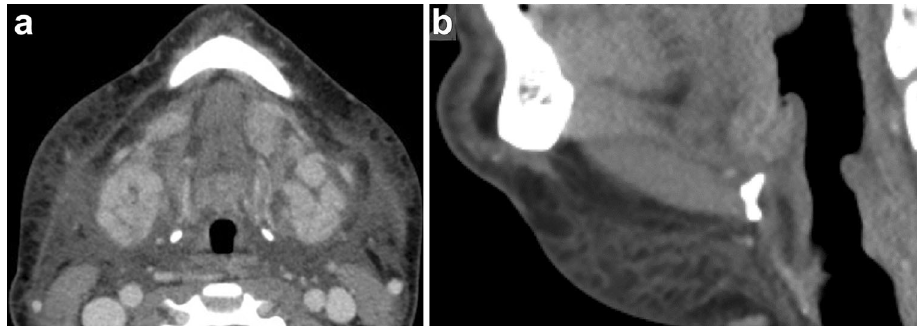
Fig. 9 Ludwig angina. a Axial and b sagittal contrast-enhanced CT images show diffuse inflammatory changes with bands of fluid within the submandibular and sublingual spaces. These changes extend posteriorly into bilateral parapharyngeal spaces, pharyngeal mucosa, and inferiorly along the anterior neck ( b